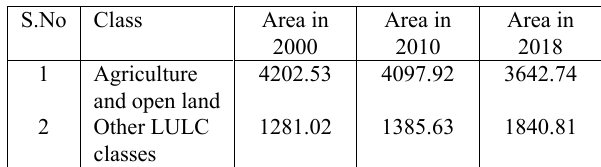
Table 2. Change in features area from year 2000 to 2018. All values of area are in km 2 .